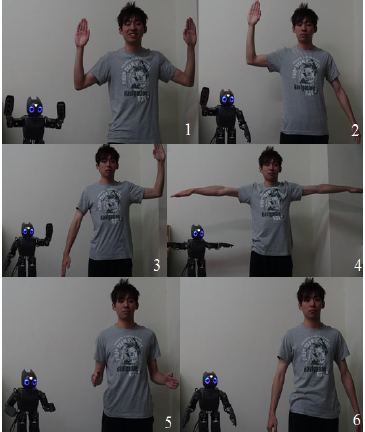
Figure 13. The emulation of humanoid robot.